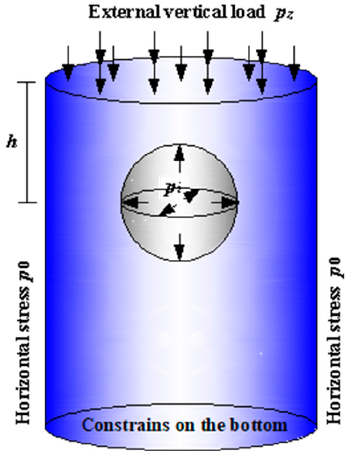
Figure 1. Limestone strata containing shallowly buried Karst caves. ( a ). Before collapse; ( b ). After collapse.